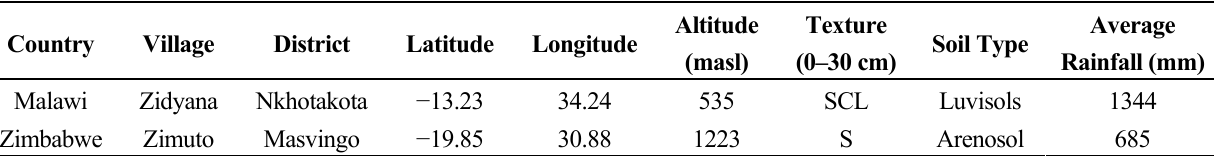
Table 1. General characteristics of the experimental sites in Malawi and Zimbabwe. Country